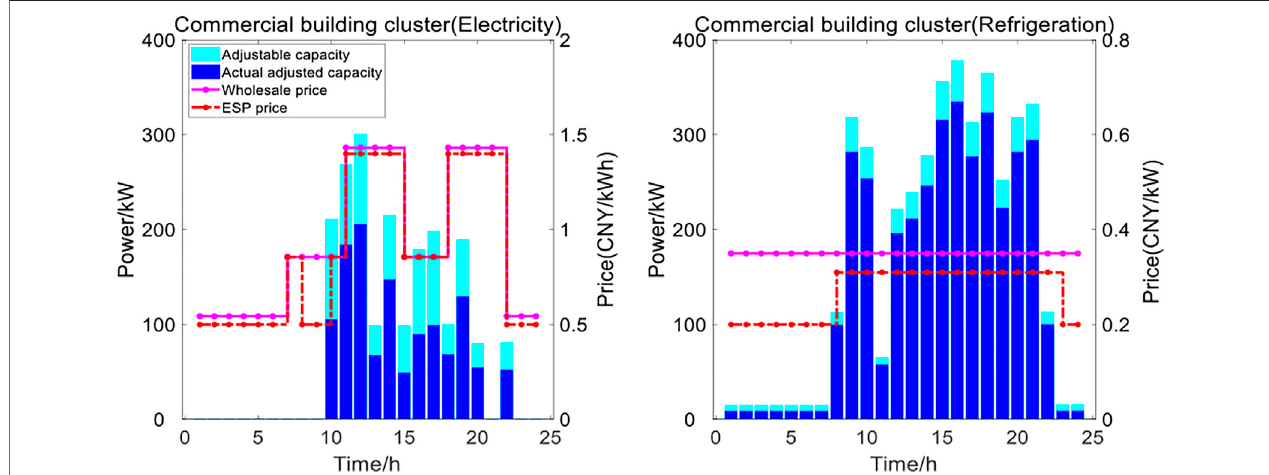
FIGURE 7 | Pricing decision-making results of Commercial building cluster.